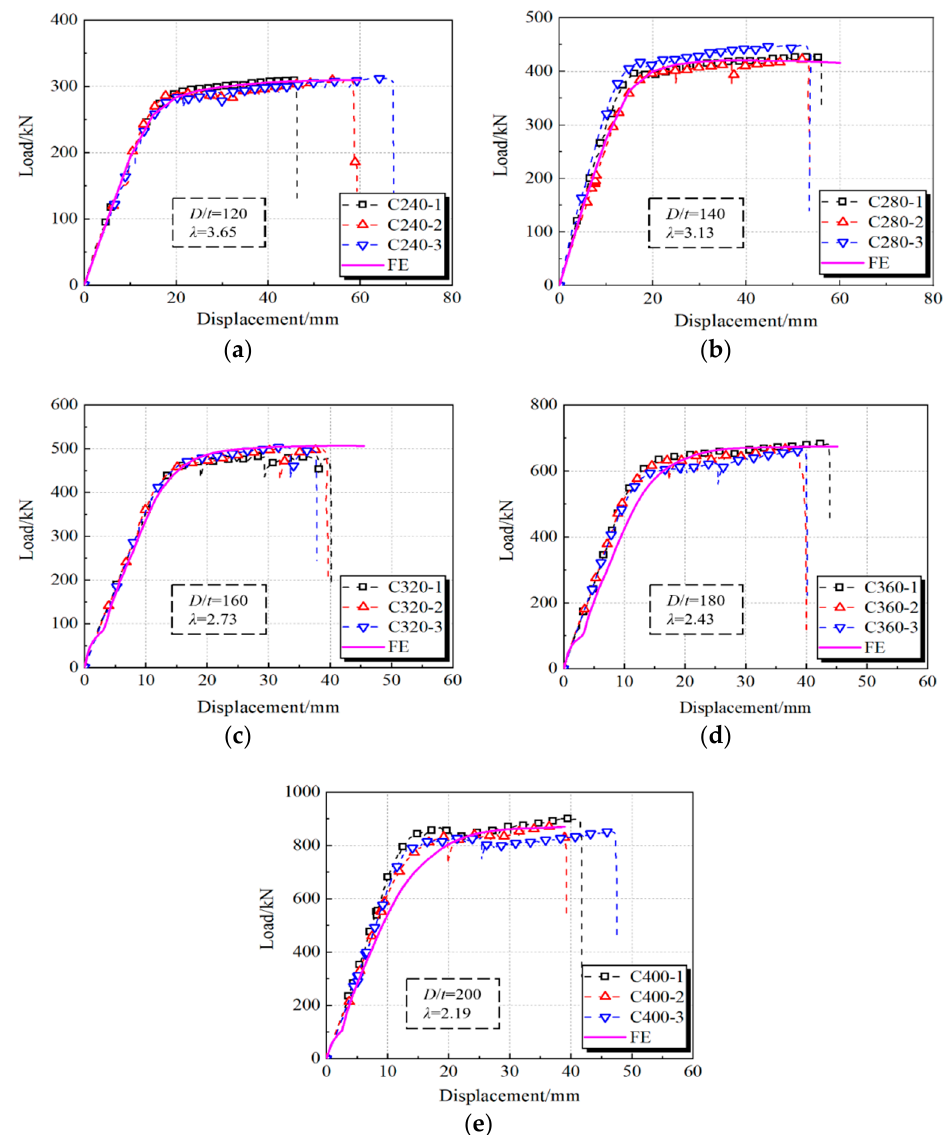
Figure 11. The results of FEM and experiment. ( a ) C240; ( b ) C280; ( c ) C320; ( d ) C360; ( e ) C400.